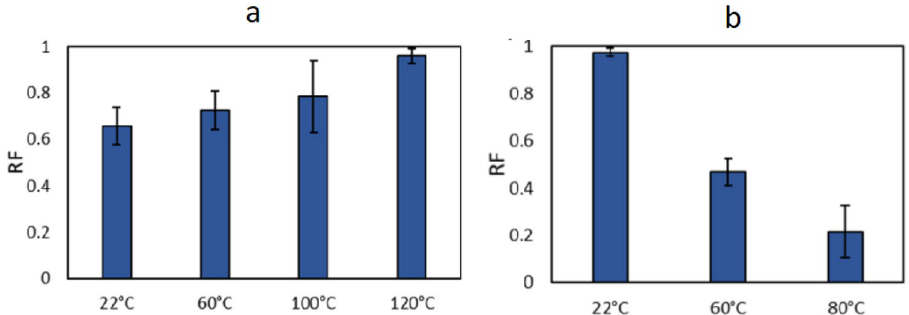
Figure 2. Crude oil A ( a ) and crude oil C ( b ) displaced by HS-Na at 2 bar and different temperatures.